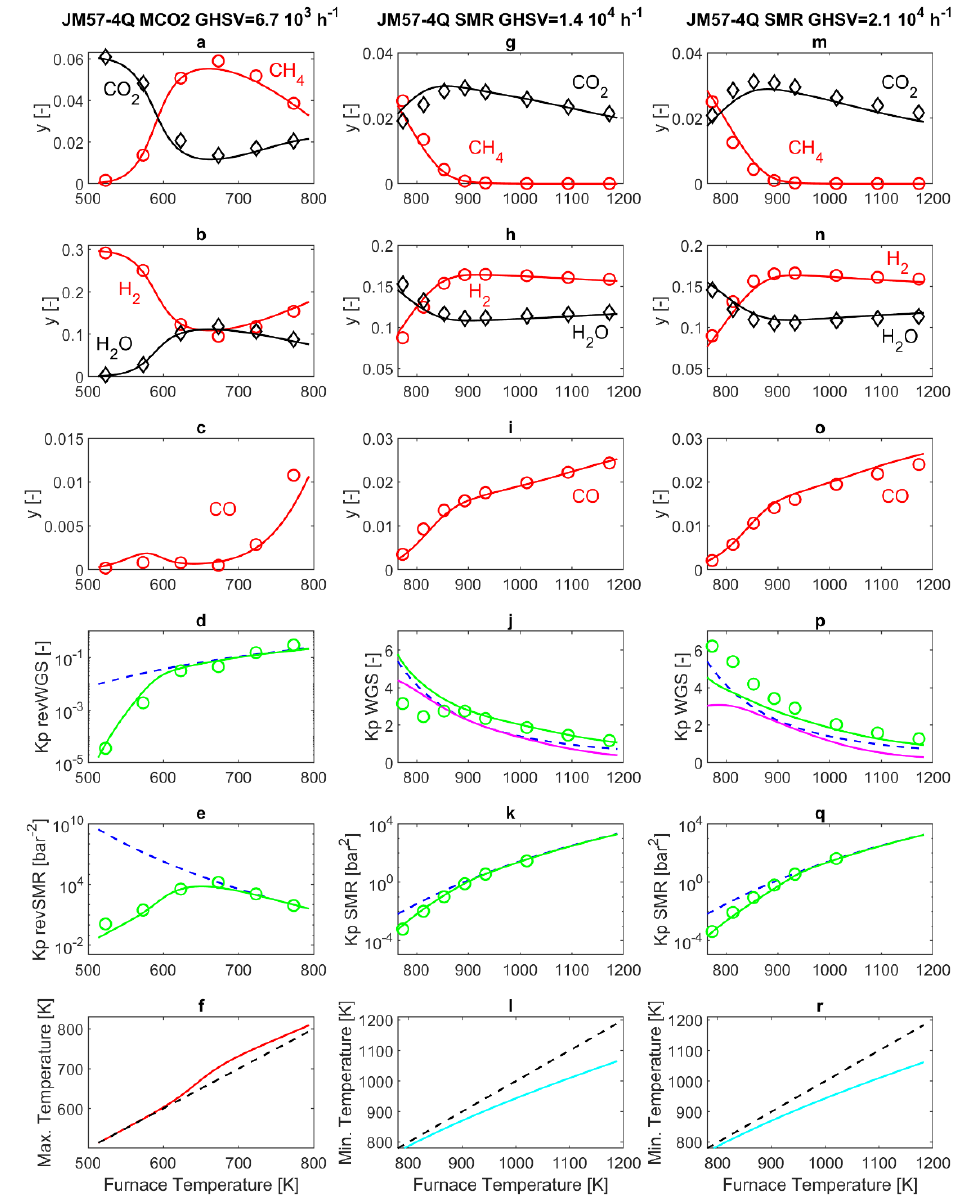
Figure 3. Results for the 57-4Q commercial catalyst. (Panels a – f ): MCO2 operating mode (GHSV = 6.7 × 10 3 h − 1 ). (Panels g – l ): SMR operating mode (GHSV = 1.4 × 10 4 h − 1 ). (Panels m – r ): SMR operating mode (GHSV = 2.1 × 10 4 h − 1 ). Symbols: experimental data. Lines: simulations. (Panels a – c , g – i , m – o ): compositions at the sampling point (exit of P-R2). (Panels d , j , p ): ━ ━ ━ Kp, WGS calculated at the furnace temperature; model calculation and ◯ experimental data of (∏ 𝑝 𝑖𝜈 𝑖 𝑖 ) at the 𝑊𝐺𝑆 sampling point (exit of P-R2). (Panels j , p ): model calculation of (∏ 𝑝 𝑖𝜈 𝑖 𝑖 ) at the exit of 𝑊𝐺𝑆 the PBR. (Panels e , k , q ): ━ ━ ━ Kp, SMR calculated at the furnace temperature; model calculation and ◯ experimental data of (∏ 𝑝 𝑖𝜈 𝑖 𝑖 ) at the sampling point (exit of P-R2). (Panels 𝑆𝑀𝑅 f , l , r ): ━ ━ ━ furnace temperature; model results of: maximum temperature in the PBR of the MCO2 reactor and minimum temperature in the PBR of the SMR reactor.